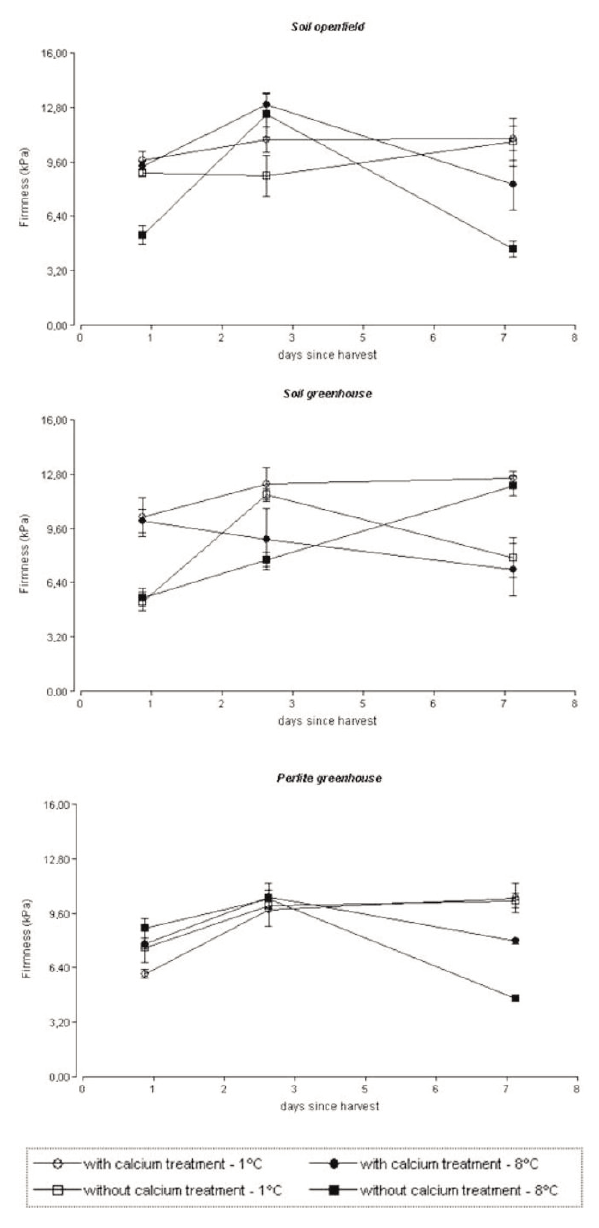
(p<0.05).Fig. 4 - Firmness (kPa) at 1, 3 and 7 days of postharvest of straw- berries grown in different growing systems, calcium lac- tate treatment and two storage Table 2 - Total soluble solids (°Brix) at 1, 3 and 7 days of postharvest of strawberries grown in different growing systems, calcium lactate treatment and two storage temperatures